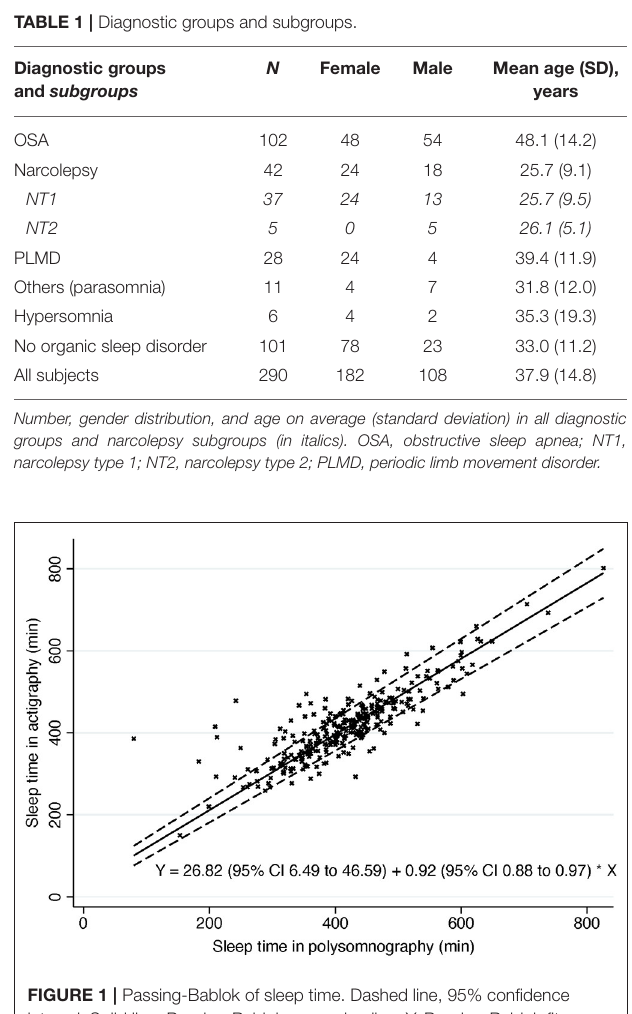
sample, and non-parametric methods were used as suggested by Bland and Altman (23). Logarithmic transformation did not change the distribution of mean differences.